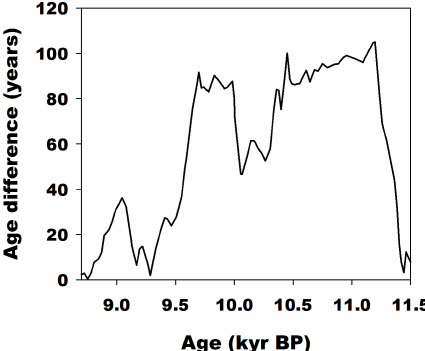
Figure 4. Age difference between the new gas age scale adjusted to GICC05 by Monte Carlo matching with NEEM discrete CH 4 (Chappellaz et al., 2013) and the original gas age based on CH 4 and δ 18 O atm correlation (Severinghaus et al.,